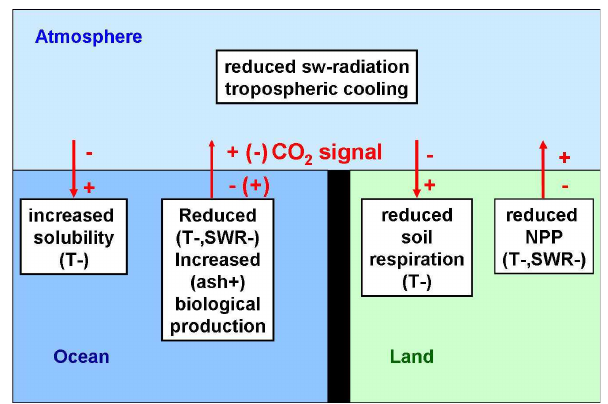
Fig. 1. Sketch of potential effects of volcanic eruptions on the carbon cycle as included in MPI-ESM. Fertilisation by ash is in- cluded for ocean only model set-up, not the ESM. ( T –) signifies in response to negative temperature anomaly, (SWR-) in response to negative short-wave radiation anomaly, and (ash +) in response to ash input from volcanic eruptions. Arrows indicate direction of anomalous CO 2 fluxes, +/– a gain/loss of the respective reservoir, (–)/(+) in response to increased ash deposition. NPP is net primary productivity, SWR – shortwave radiation, T –